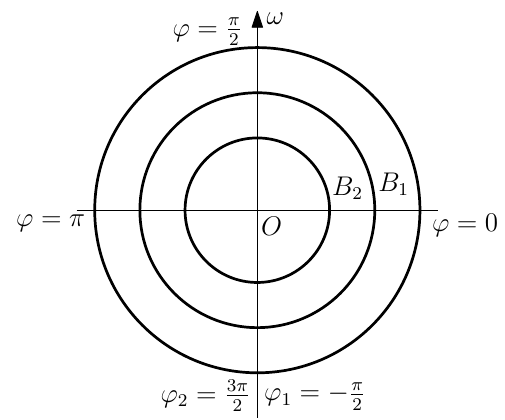
Figure 21: Plot of σ φ as a function of r for φ i ( i = 5 . . . 7) (Example 5.2).